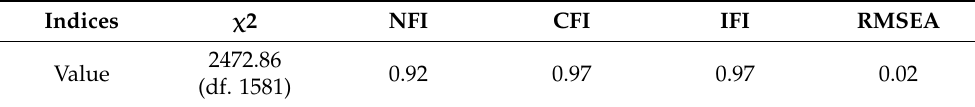
Table 2. Indices of fit of the